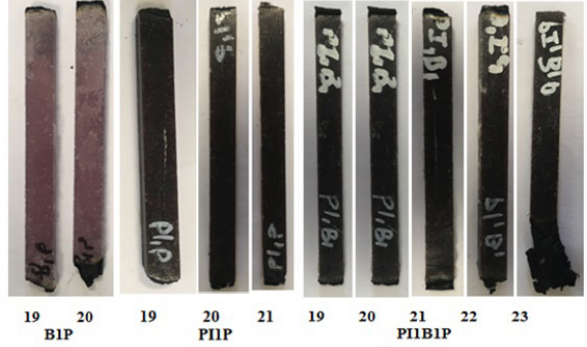
Figure 4: Composite samples taken from LOI test.